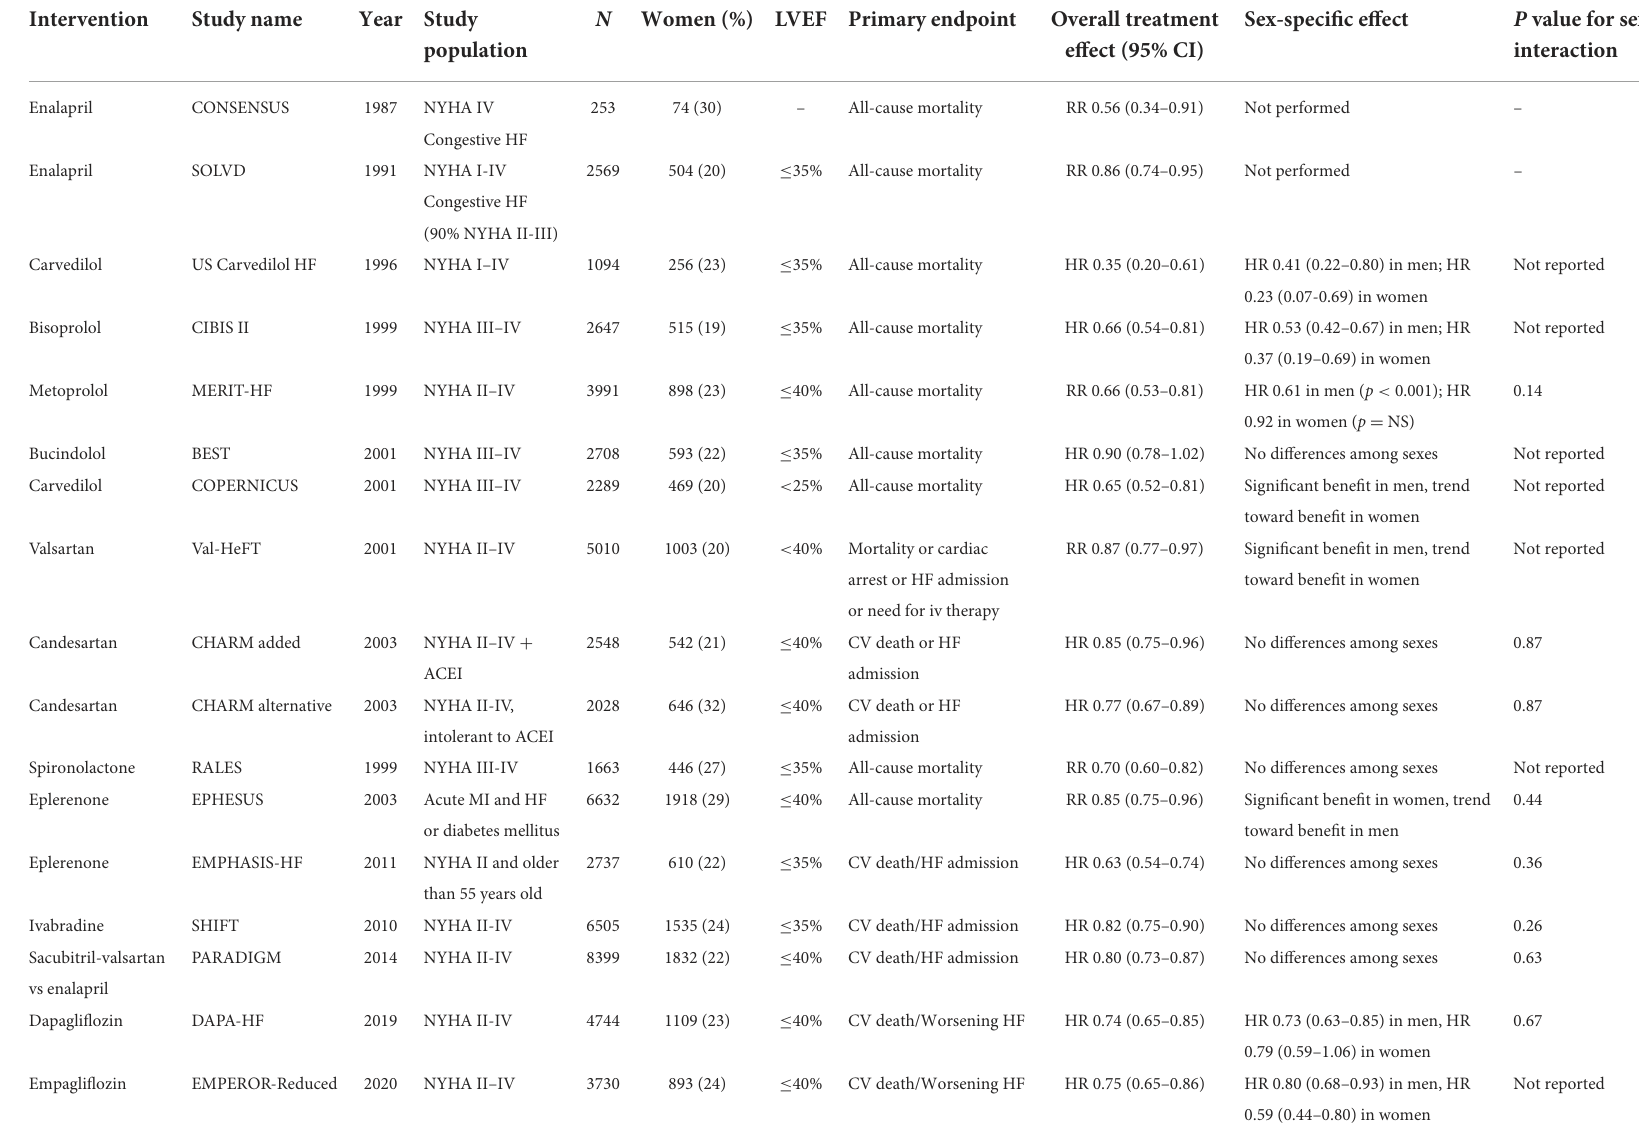
TABLE 1 Randomized clinical trials for drugs in HFrEF included in the systematic